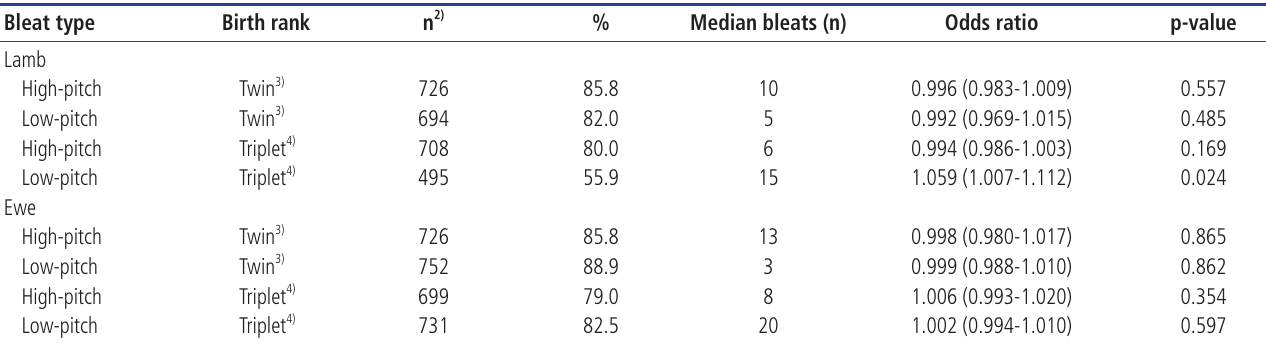
Table 2. Twin- and triplet-lamb bleating behaviour 1)